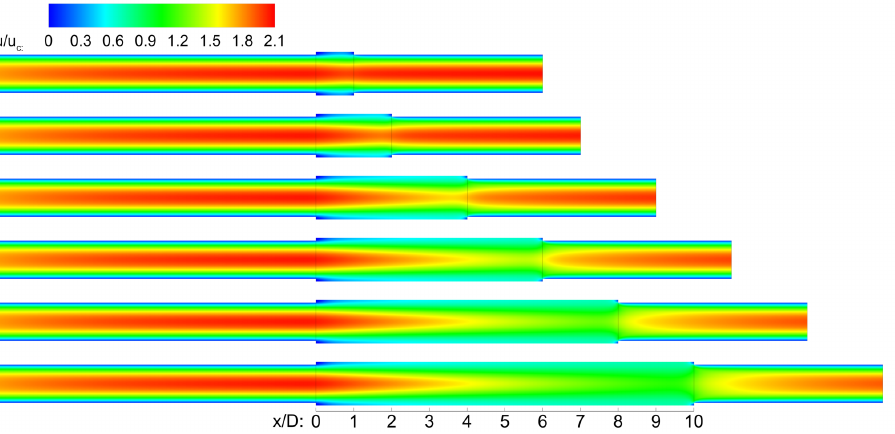
1 Figure 4. Effect of increasing the spacing between substrates at a constant Re. Re = 200. The contours are from planes along of the center of the